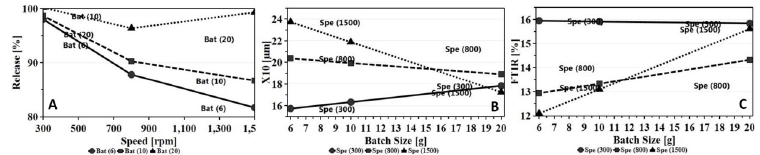
Fig 9. Interaction effect plot of speed with increasing batch size on (A) dissolution rate (B) PSA and (C) FTIR spectrum while the other factors were maintained at their middle values.